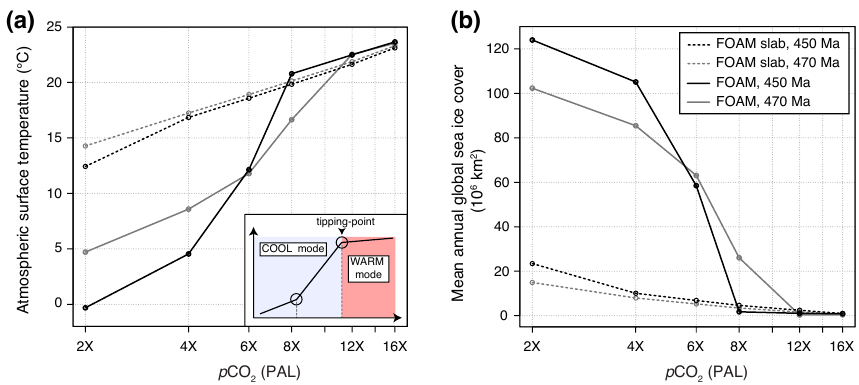
Figure 2. (a) Mean annual, globally averaged surface air temperature for various p CO 2 values from 2 to 16PAL, with the slab-version of FOAM and with the fully coupled ocean–atmosphere–sea ice version of FOAM at 470 and at 450Ma. The sketch illustrates the explanations provided in the main text. Note the logarithmic scale on the x axis. (b) Same plot as (a) , for the mean annual global sea ice cover expressed in Mkm − 2 .